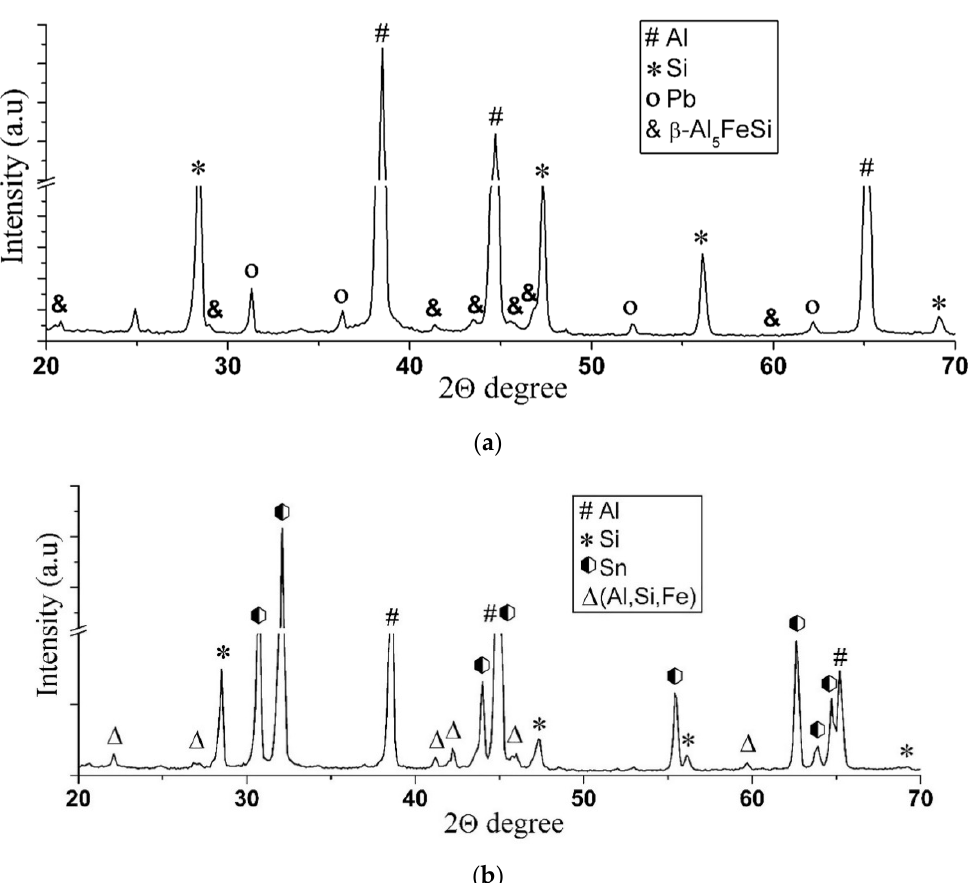
Figure 8. The diffraction pattern of a coating made of the AlSi12 alloy with a lead sublayer ( a ) and with the addition of tin ( b ).